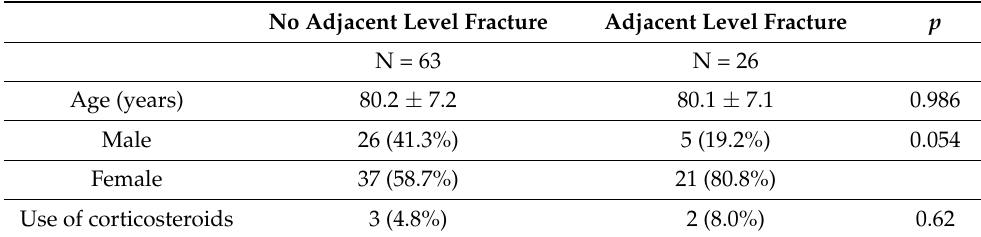
Table 1. Patient demographics and baseline